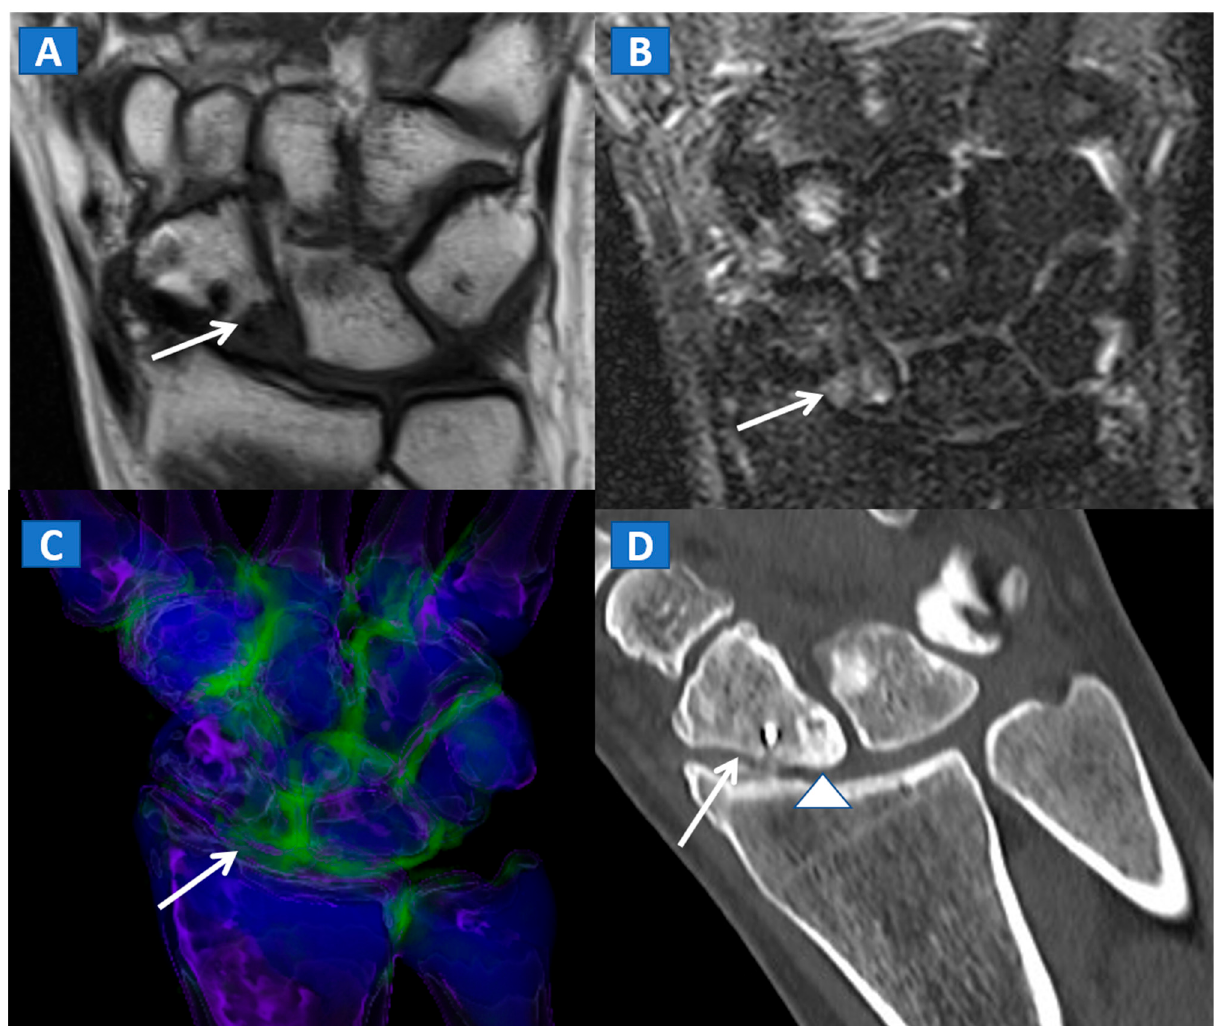
Figure 9. A 45-year-old male with persistent pain after surgical fixation of a middle-third carpal scaphoid fracture. On the coronal T1-weighted ( A ) and STIR ( B ) MRI images, metal-induced and motion artifacts impede the correct evaluation of the healing process. Furthermore, subtle BME is depicted proximally (arrow). On the 3D DECT image ( C ), some proximal BME can be confirmed (arrow). On the 1 mm reconstructed standard CT image on the coronal plane ( D ), the BME appears as an area of increased density (arrowhead). There are no signs of any residual fractures adjacent to the inserted metallic hardware.